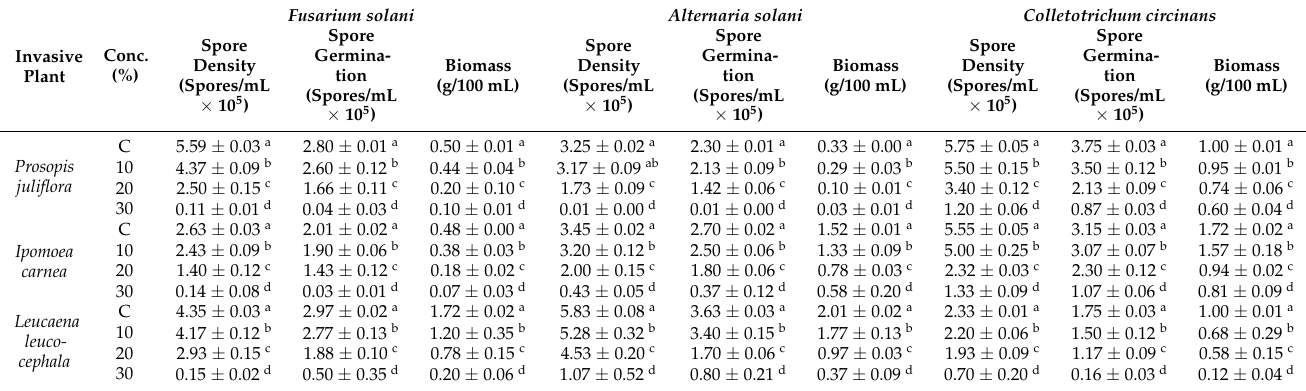
Table 4. Inhibitory effects of three concentrations of leaf extracts from the three invasive plants on spore density, spore germination, and biomass of the three fungal species, Fusarium solani , Alternaria solani , and Colletotrichum circinans , under in vitro